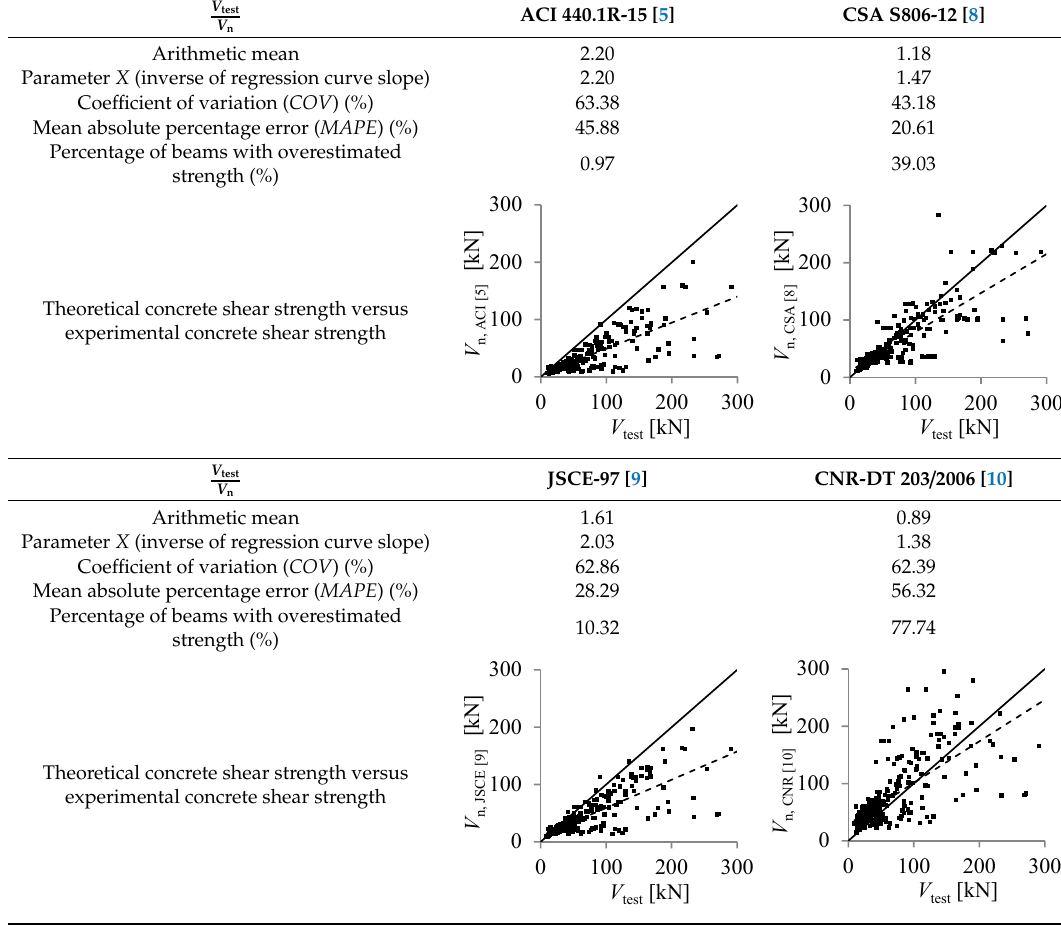
Table 3. Comparison of experimental ( V test ) and theoretical ( V n ) values of the concrete shear strength for available design recommendations. Results according to Equations (2), (7), (13) and (17).